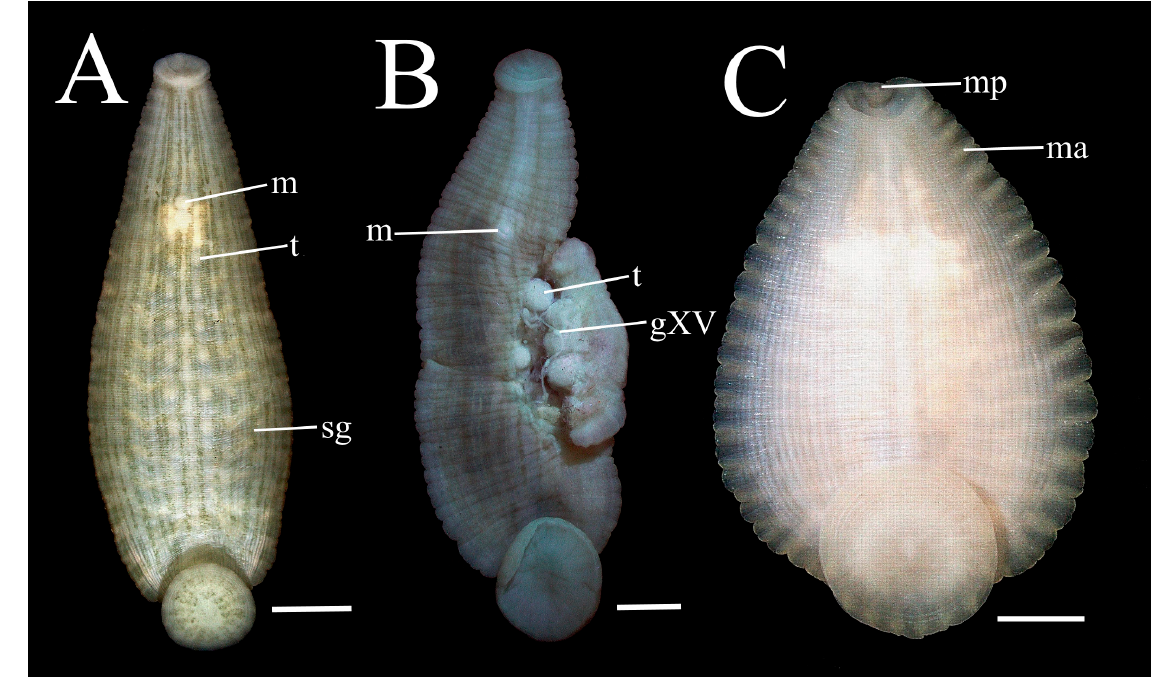
Figure 3. Ventral views of P. parasitica from Outer Banks. Shown are the same three individuals as Figure 2. Note the green longitudinal stripes so evident in ( A ) are not reliable taxonomic characters in ( B , C ). Abbreviations: gXV, ganglion 15; m, male gonopore; ma, metameric marginal pattern; mp, mouth pore; sg, green stripe; t testisac. Same scale bars as Figure 2.